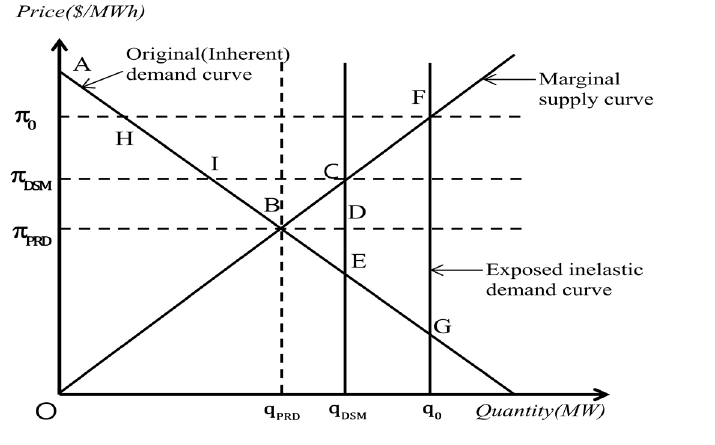
Figure 1. Social welfare with conventional scheduling, DSM scheduling and PRD contained